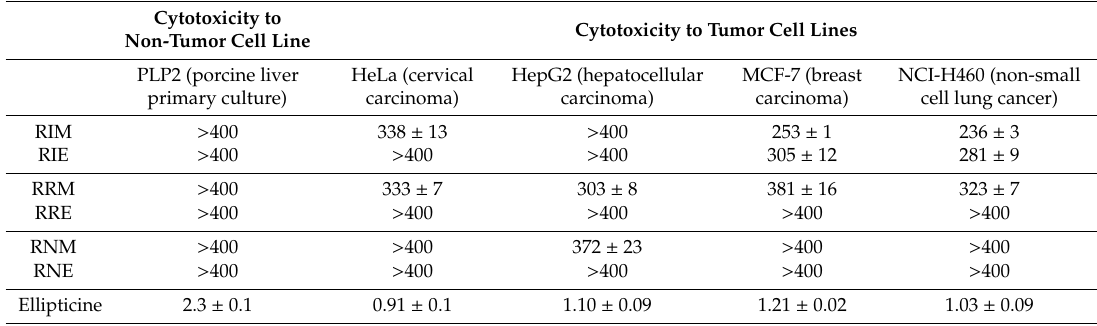
Cytotoxicity to Tumor Cell